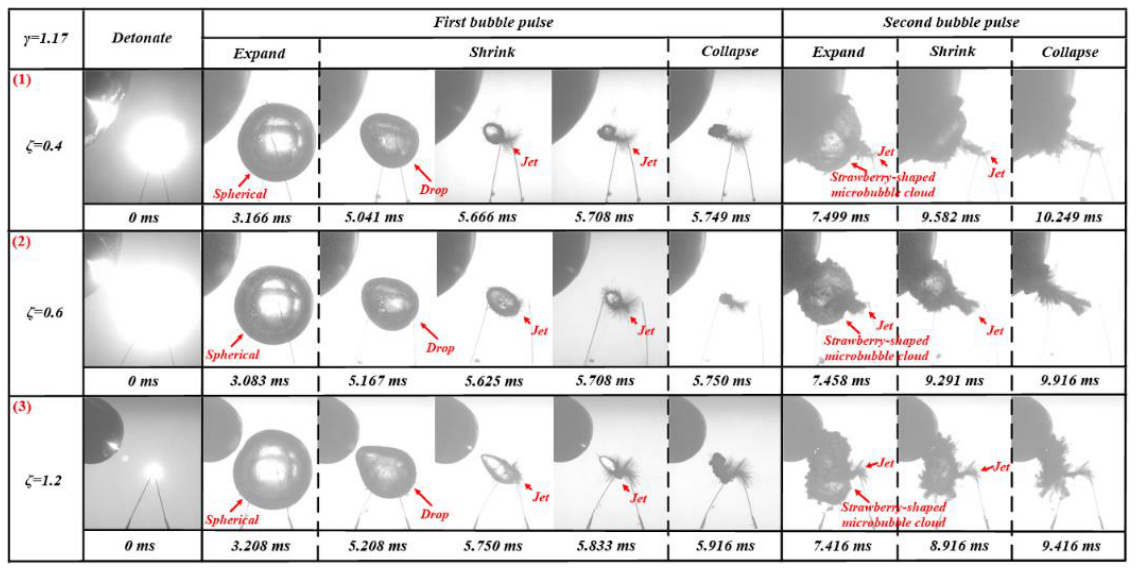
Figure 15. Type V bubble pulsation process diagram. ( 1 ) The bubble pulsation process when ζ = 0.4 and γ = 1.17. ( 2 ) The bubble pulsation process when ζ = 0.6 and γ = 1.17. ( 3 ) The bubble pulsation process when ζ = 1.2 and γ = 1.17.